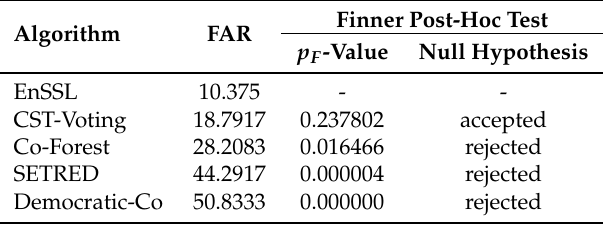
Table 9. Friedman Aligned Ranking (FAR) test and Finner post-hoc test for SETRED, Co-Forest, Democratic-Co learning, CST-Voting and